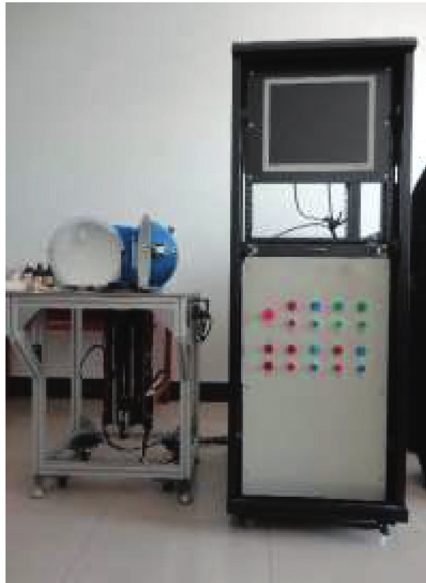
Figure 9: Photoelectric detection system for the compensation hole of the automobile brake master